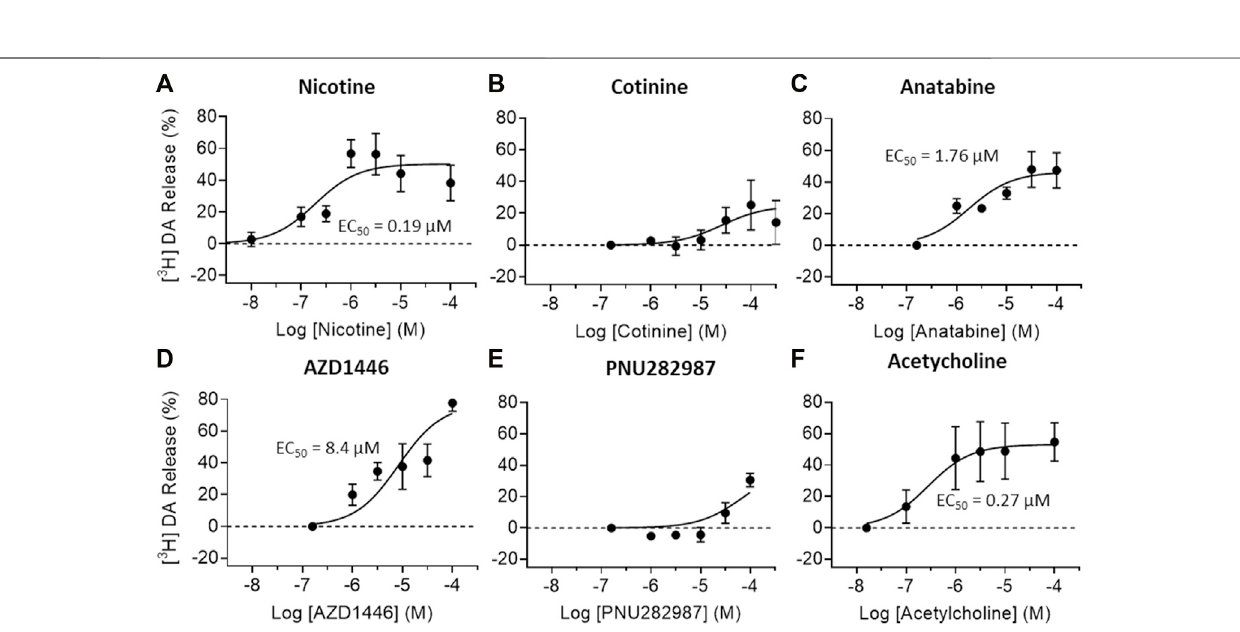
FIGURE 4 | Effects of nAChR ligands on dopamine release in vitro . Dopamine (DA) release from crude striatal synaptosome preparations were measured after (A) nicotine, (B) cotinine, (C) anatabine, (D) AZD1446 (E) PNU282987, and (F) acetylcholine treatment. All tested compounds elicited robust DA release exceptfor cotinine and PNU282987 at the concentrations tested. Data are presented as mean ±